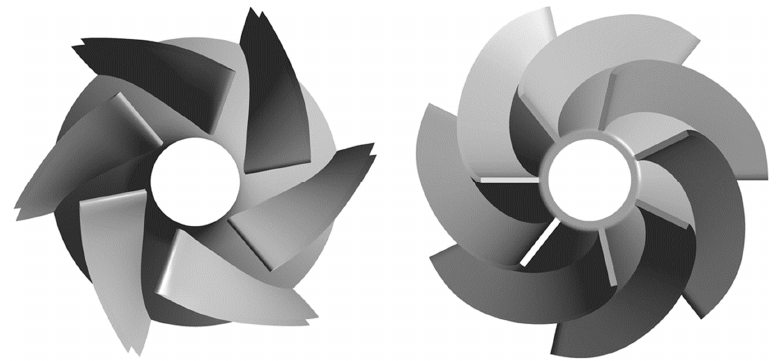
Figure 1. Three-dimensional model of mixed-flow centrifugal pump.